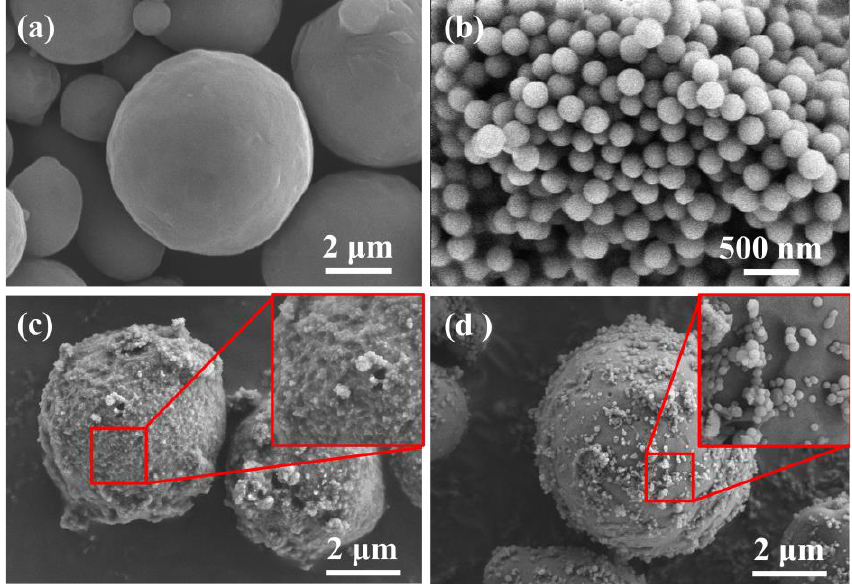
Figure 1. SEM images of Al powders ( a ), PVDF powders ( b ), Al@PVDF powders ( c ), and Al/PVDF powders ( d ).